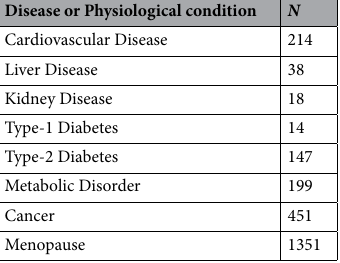
Table 1. Number of participants diagnosed by disease or physiological condition on and before their first imaging visit out of the 3088 included in the